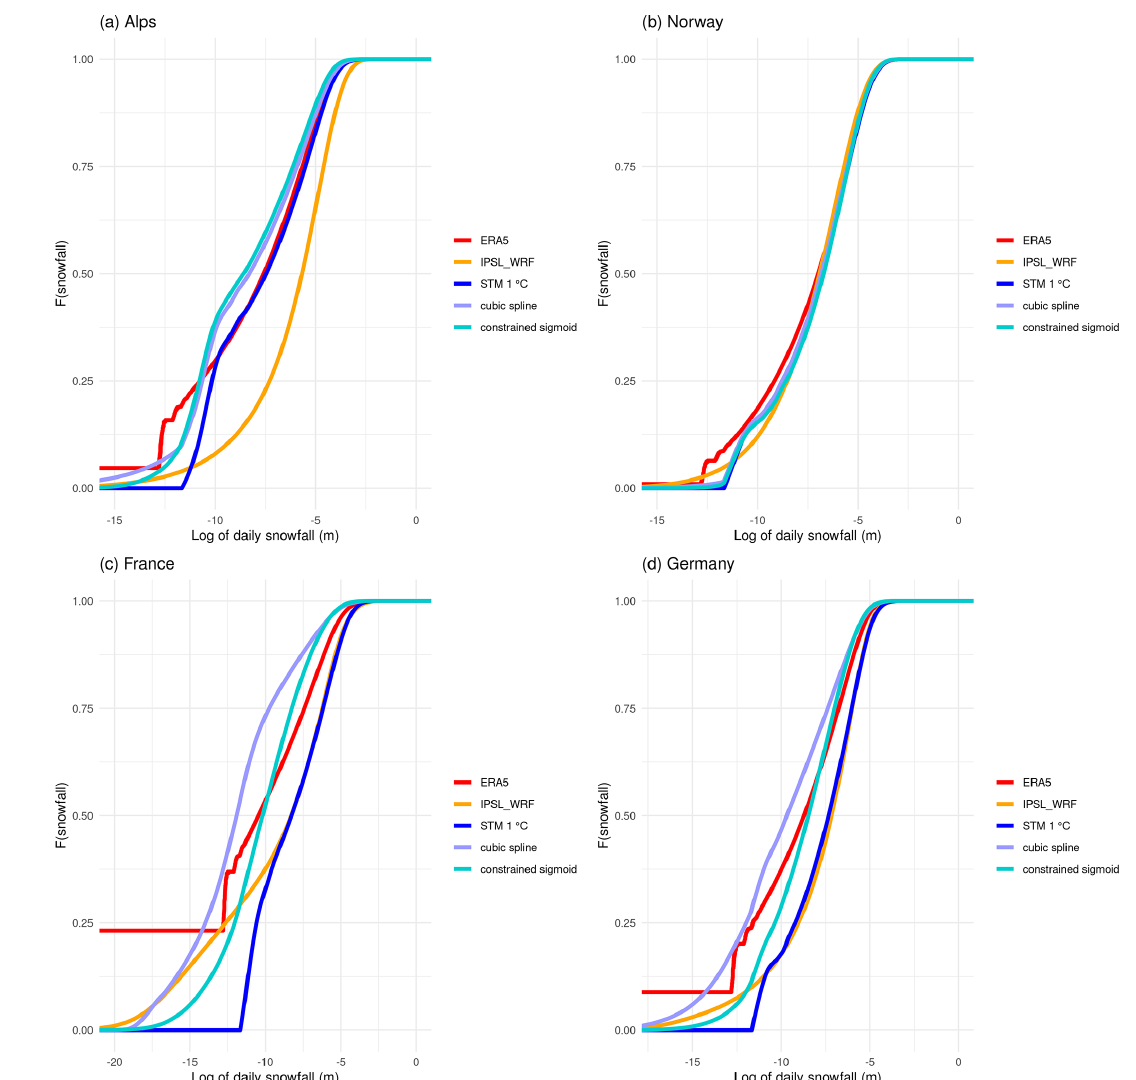
Figure 14. Comparison between cumulative distribution function of daily snowfall in ERA5 reanalysis (red lines), raw IPSL_WRF model output (orange line), STM (blue line), cubic spline (purple line), and constrained sigmoid (turquoise line) bias correction for (a) the Alps, (b) Norway, (c) France, and (d) Germany. The distributions are shown in a natural logarithmic scale to magnify the